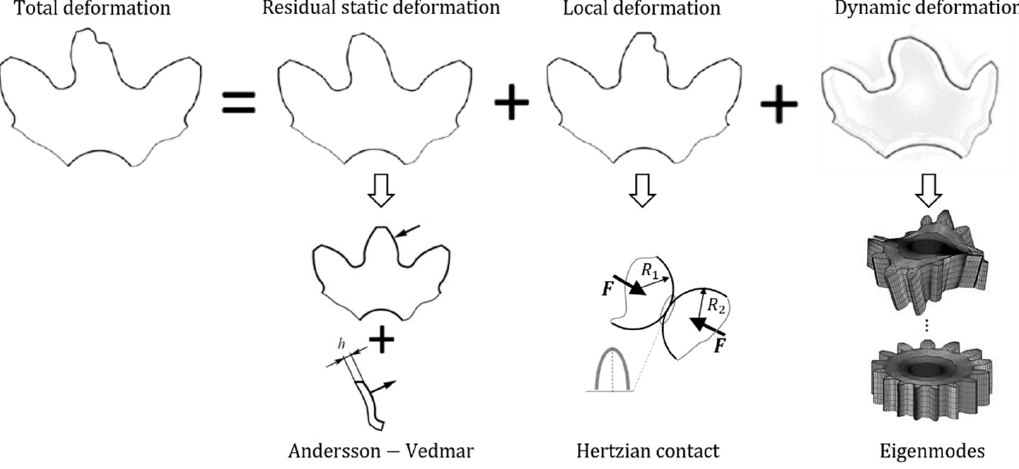
Figure 4. Computation of the required amount of deflection.